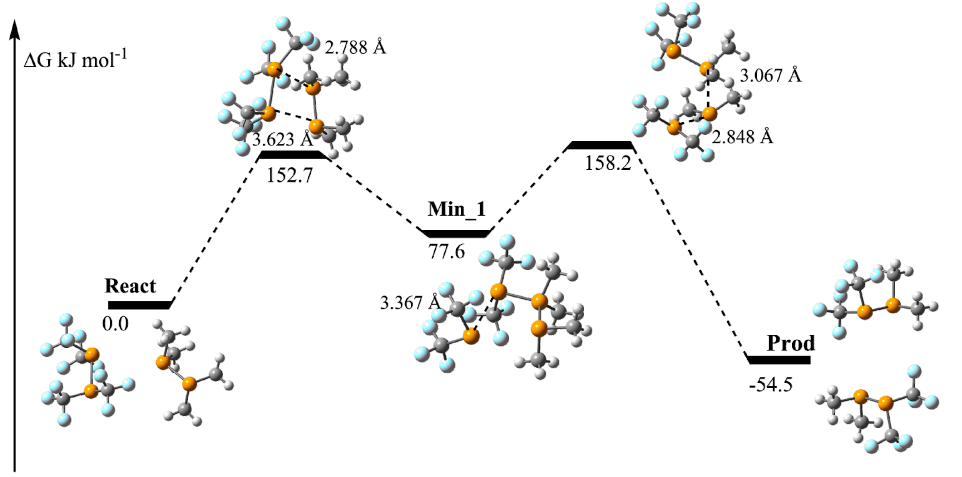
Figure 2. Potential energy surface corresponding to the metathesis of Me 4 P 2 + (CF 3 ) 4 P 2 → 2Me 2 (CF 3 ) 2 P 2 at the PCM DCM /B3LYP/6-311++G(d,p). Blue, orange, grey and white atoms corresponds to F, P, C and H atoms respectively.